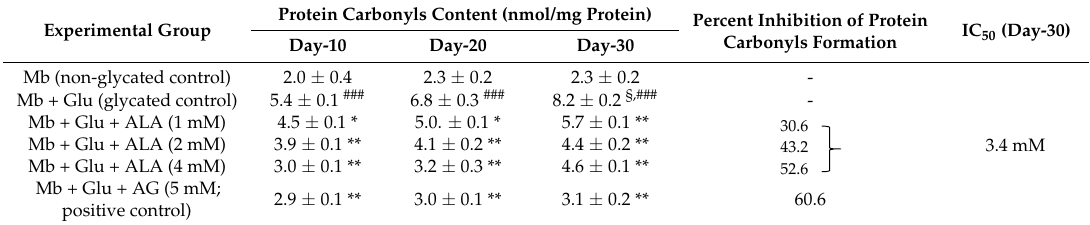
Table 3. Effect of α -lipoic acid on protein carbonyls content in glucose-induced myoglobin glycation. Experimental Group